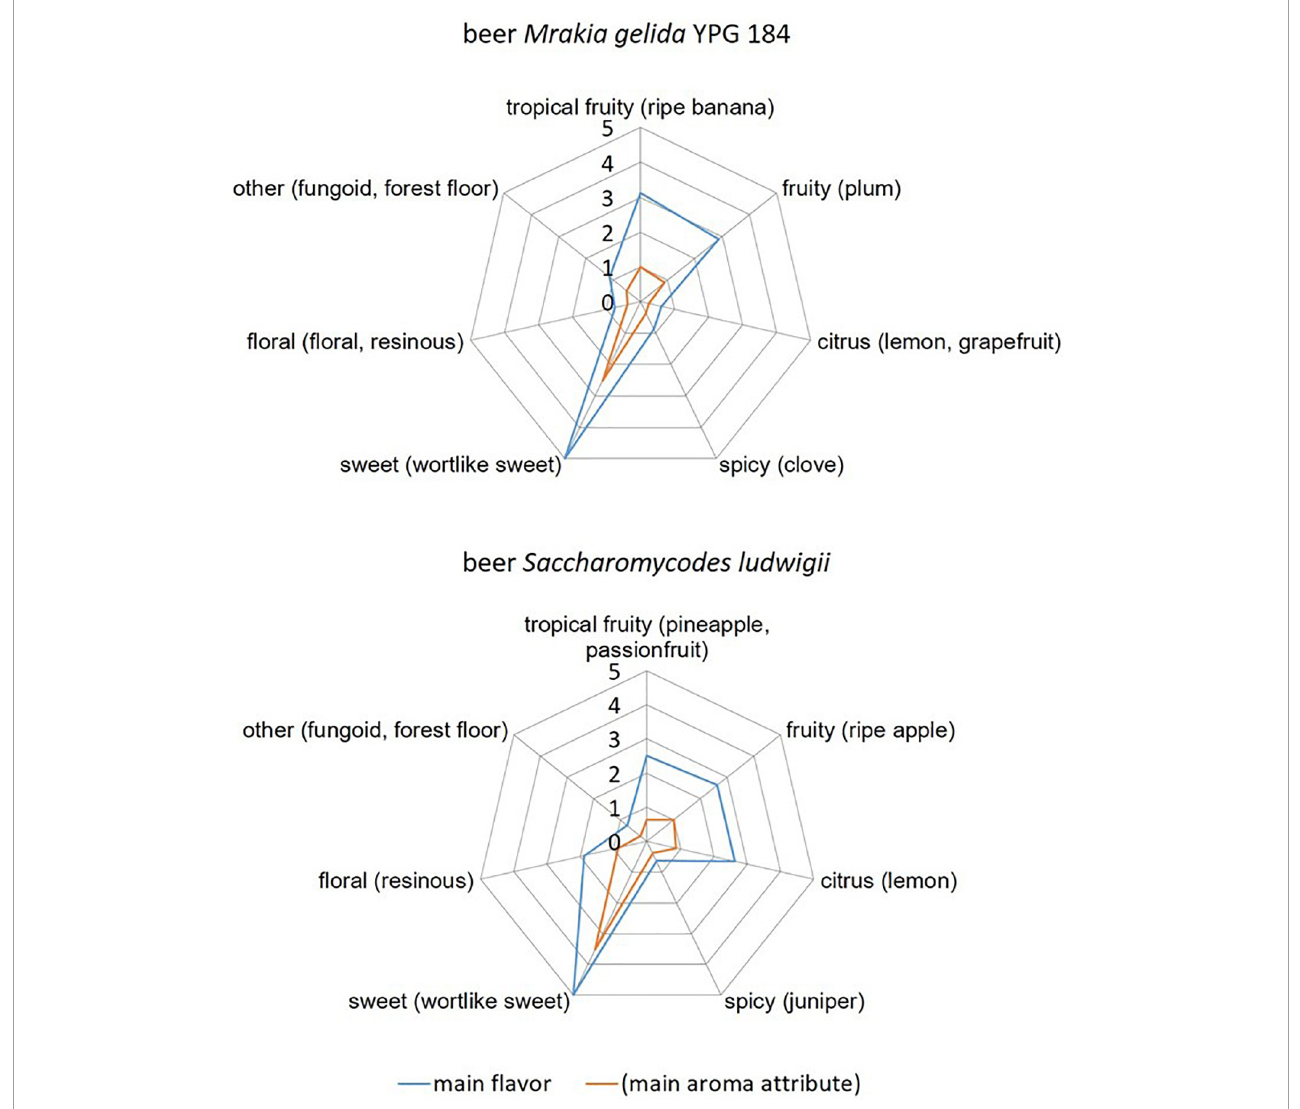
FIGURE3 Comparison of the flavors grouped according to the main flavors (sum parameter) and the respective main aroma attribute for beer produced with the yeast strains Mrakia gelida YGW 184 (top) and Saccharomycodes ludwigii (bottom)